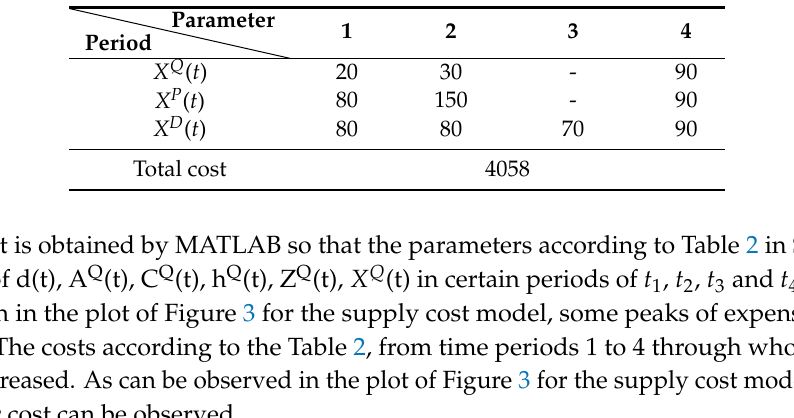
Table 5. The Total cost of integrated manufacturing functions as Optimum result.